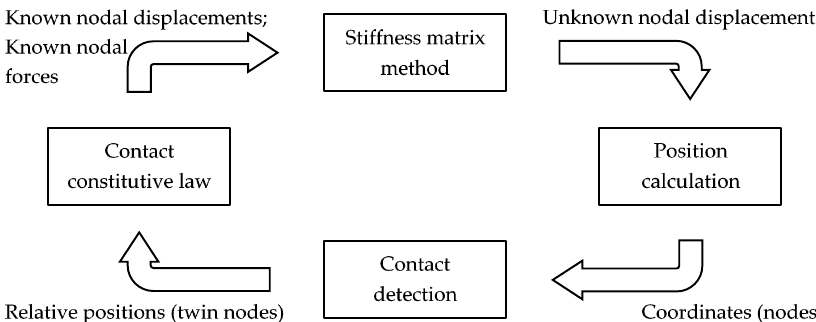
Figure 8. The DECM stabilization procedure to take into account both the compatibility and the equilibrium on the interfaces.